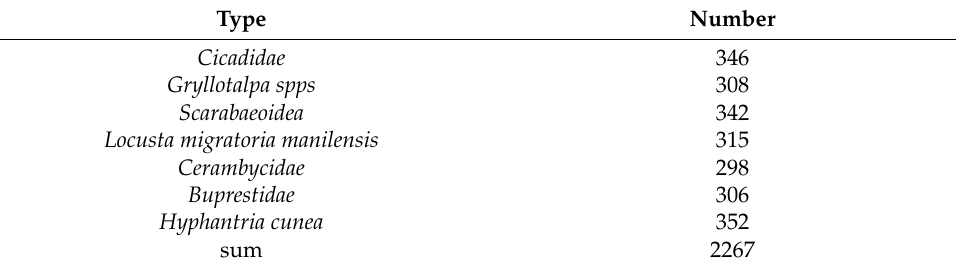
Table 2. Images from laboratory specimen.